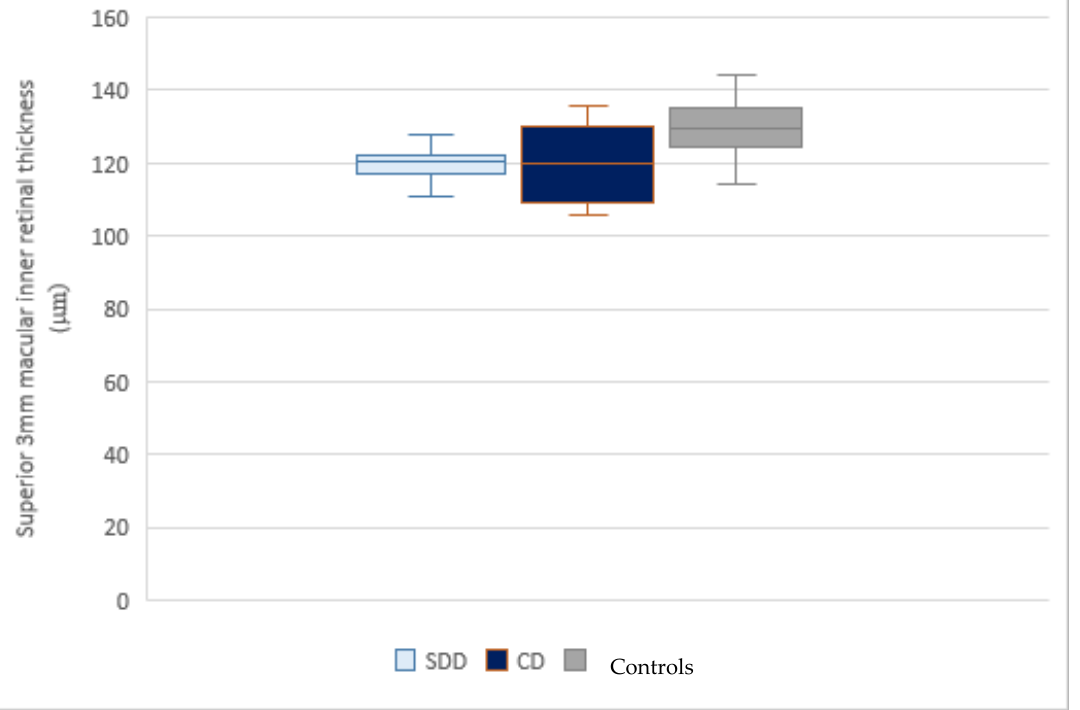
Figure 3. Box-plots of inner retina thickness in the superior 3 mm diameter in SDD group, CD group and controls. The superior 3mm inner retina thickness in healthy eyes is greater than in eyes with SDD or CD. The whiskers represent the lower and upper quartile.